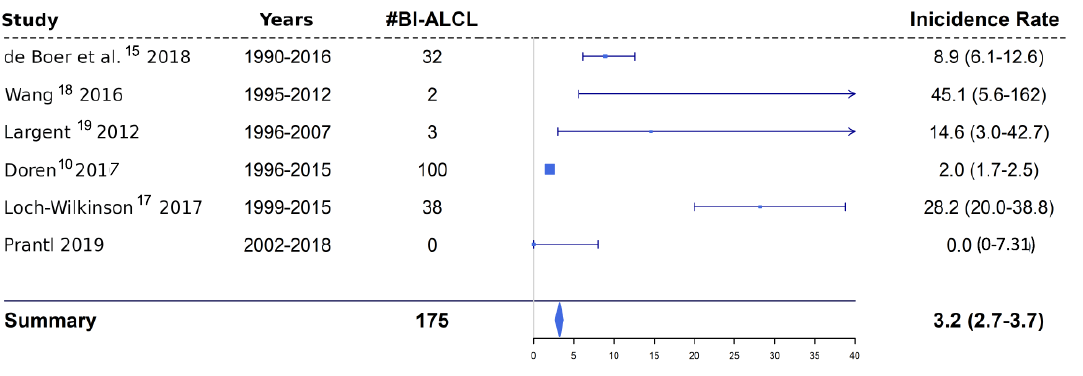
Figure 2. Forest plot showing the incidence rates and confidence intervals of five previous studies in comparison to the Regensburg data. #BI-ALCL = number of breast implant anaplastic large cell lymphomas.